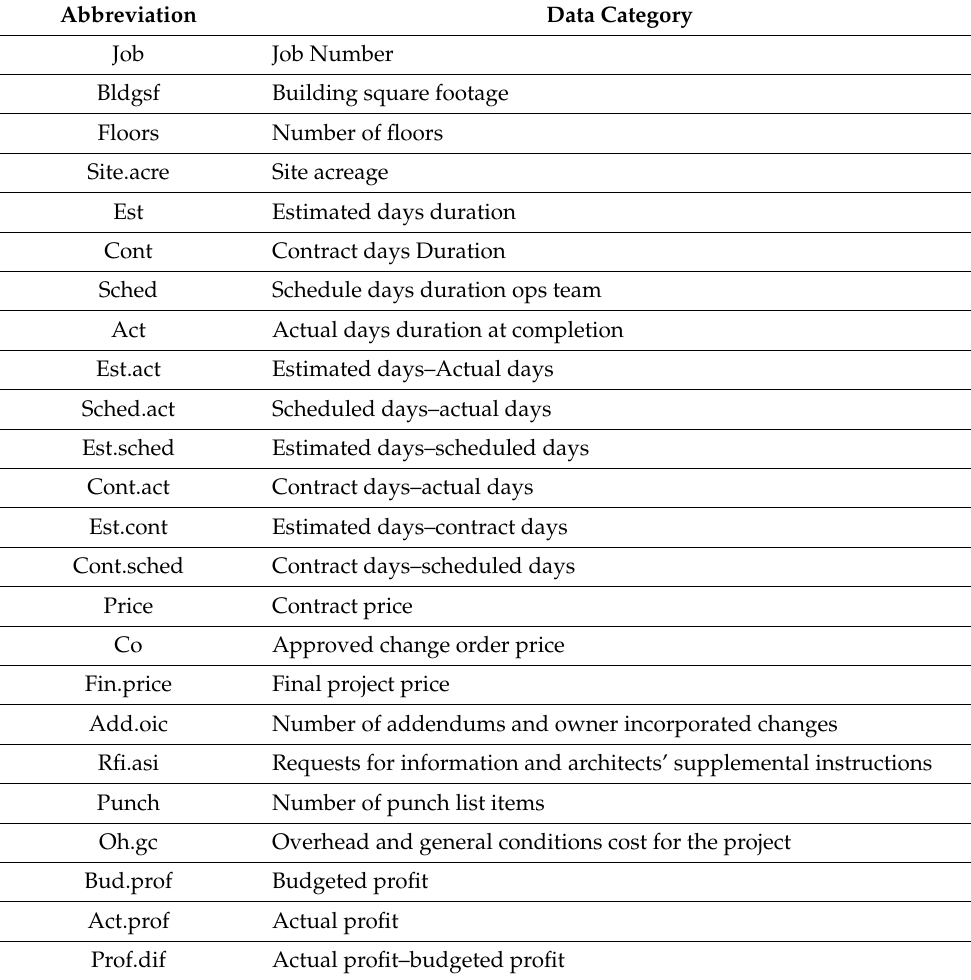
Table 2. Project data factor